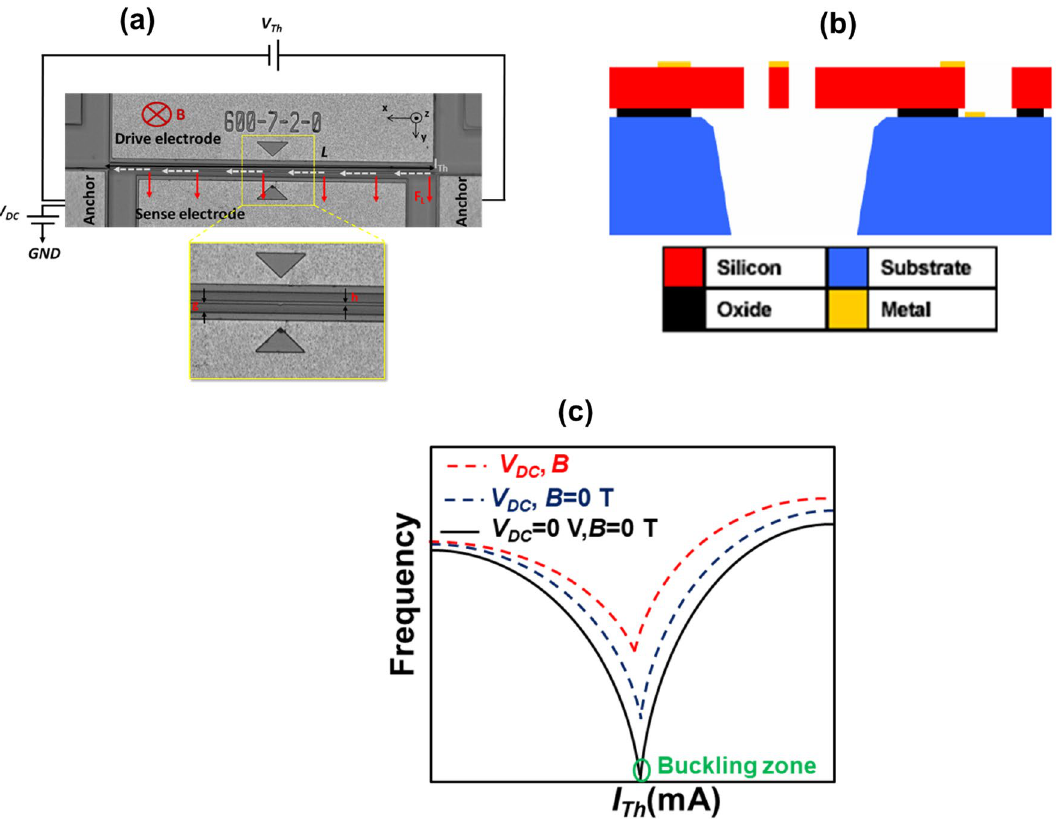
Figure 1. ( a ) Optical image of the in-plane clamped–clamped micro-beam with the geometrical parameters. ( b ) Cross-sectional view of the fabricated structure by SOIMUMPs. ( c ) Schematic illustrating the shift in